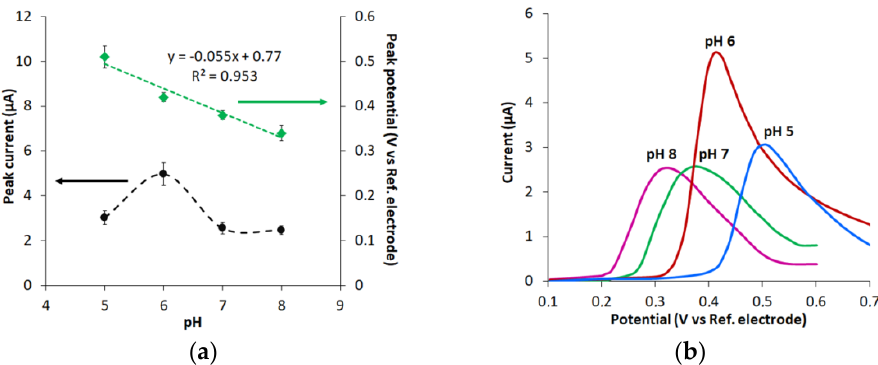
Figure 5. The effect of background electrolyte pH on UA oxidation peak current (I p ) and peak potential (E p ) on CVE act at 2.0 V ( a ); and the corresponding LS voltammograms for 0.01 mM UA in PB ( b ). Potential scan rate 0.05 Vs − 1 .